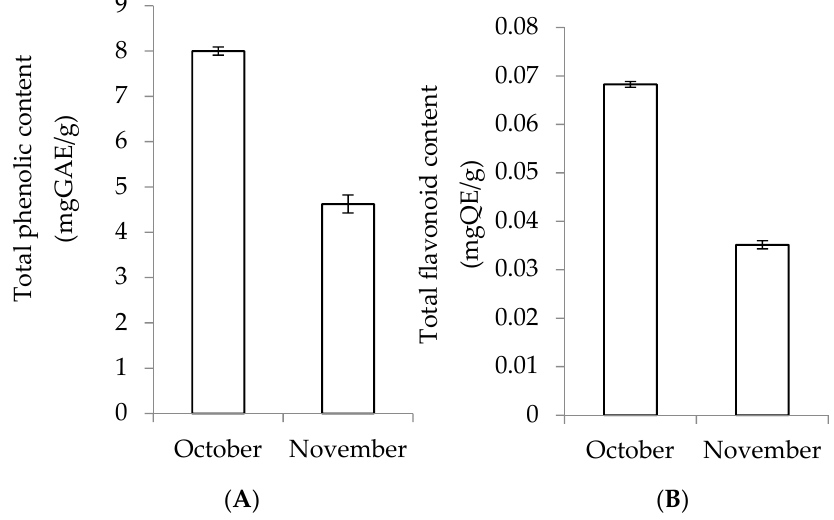
Figure 1. ( A )Total phenolic content, and ( B ) total flavonoid content of A. japonica